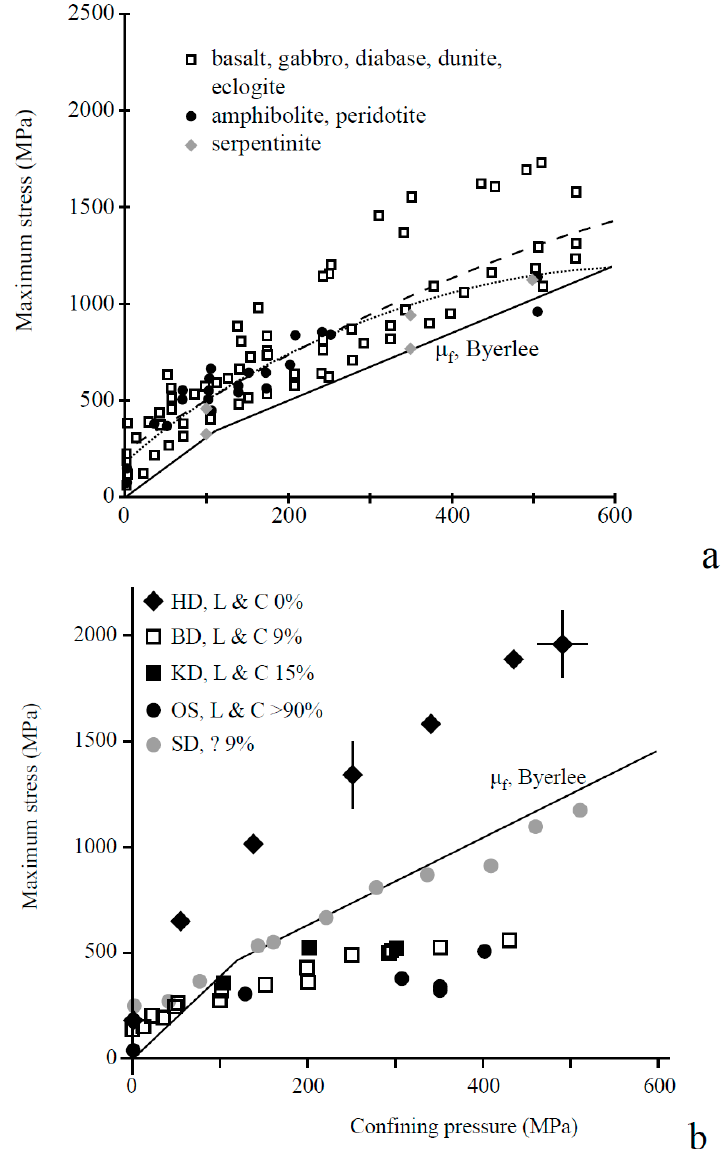
Figure 1. ( a ) Shear failure data for various ultramafic and mafic rocks with representative curves and a failure envelope based on Byerlee’s law (with μ = 0.85 and S 0 = 0 at low confining pressure, and μ = 0.6 and S 0 = 50 MPa at higher confining pressure) (figure from [32]), plus shear failure data for (antigorite-chrysotile) serpentinites (from [33]). ( b ) Shear failure data for various ultramafic rocks presented by [28]. Data reported for Horoman Dunite (HD), Balsam Gap Dunite (BD), Kükes Dunite, oceanic serpentinite (OS), and Spruce Pine Dunite (SD). L and C are the serpentine phases Lizardite and Chrysotile, ? is an unreported phase (figure from [28]). Table 3. Values from the literature for the uniaxial compressive strength ( C 0 ), cohesive shear strength ( S 0 ) and internal friction coefficient ( μ ) of various ultramafic and mafic rocks, including Columbia River Basalts.